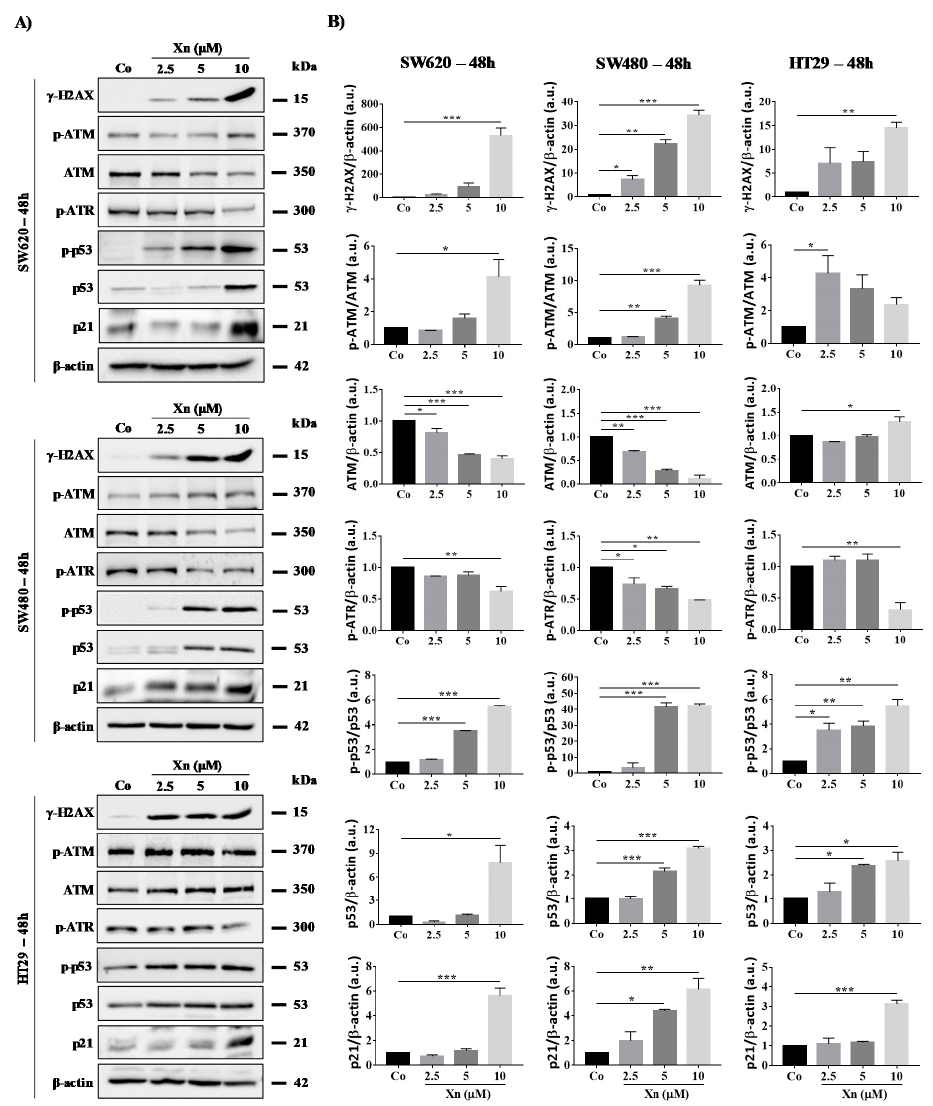
Figure 6. Xanthohumol (Xn) induces a DNA damage pathway in colon cancer cell lines after 48 h of treatment. ( A ) Immunoblotting analysis of phosphorylated H2AX, phospho-ATM, ATM, phospho-ATR, phospho-p53, p53, and p21 in the three colon cancer cell lines SW620, SW480, and HT29. Cells were incubated with increasing concentrations of Xn (0, 2.5, 5, and 10 µM) for 48 h. β -actin: loading control. One representative example of three independent experiments. ( B ) Densitometry quantification of western blotting obtained in Figure 6A. Data are expressed as mean fold induction ± SEM of three independent experiments. p values were determined by a one-way ANOVA followed by Tukey’s multiple comparison test. * p < 0.05, ** p < 0.01, and *** p < 0.001.